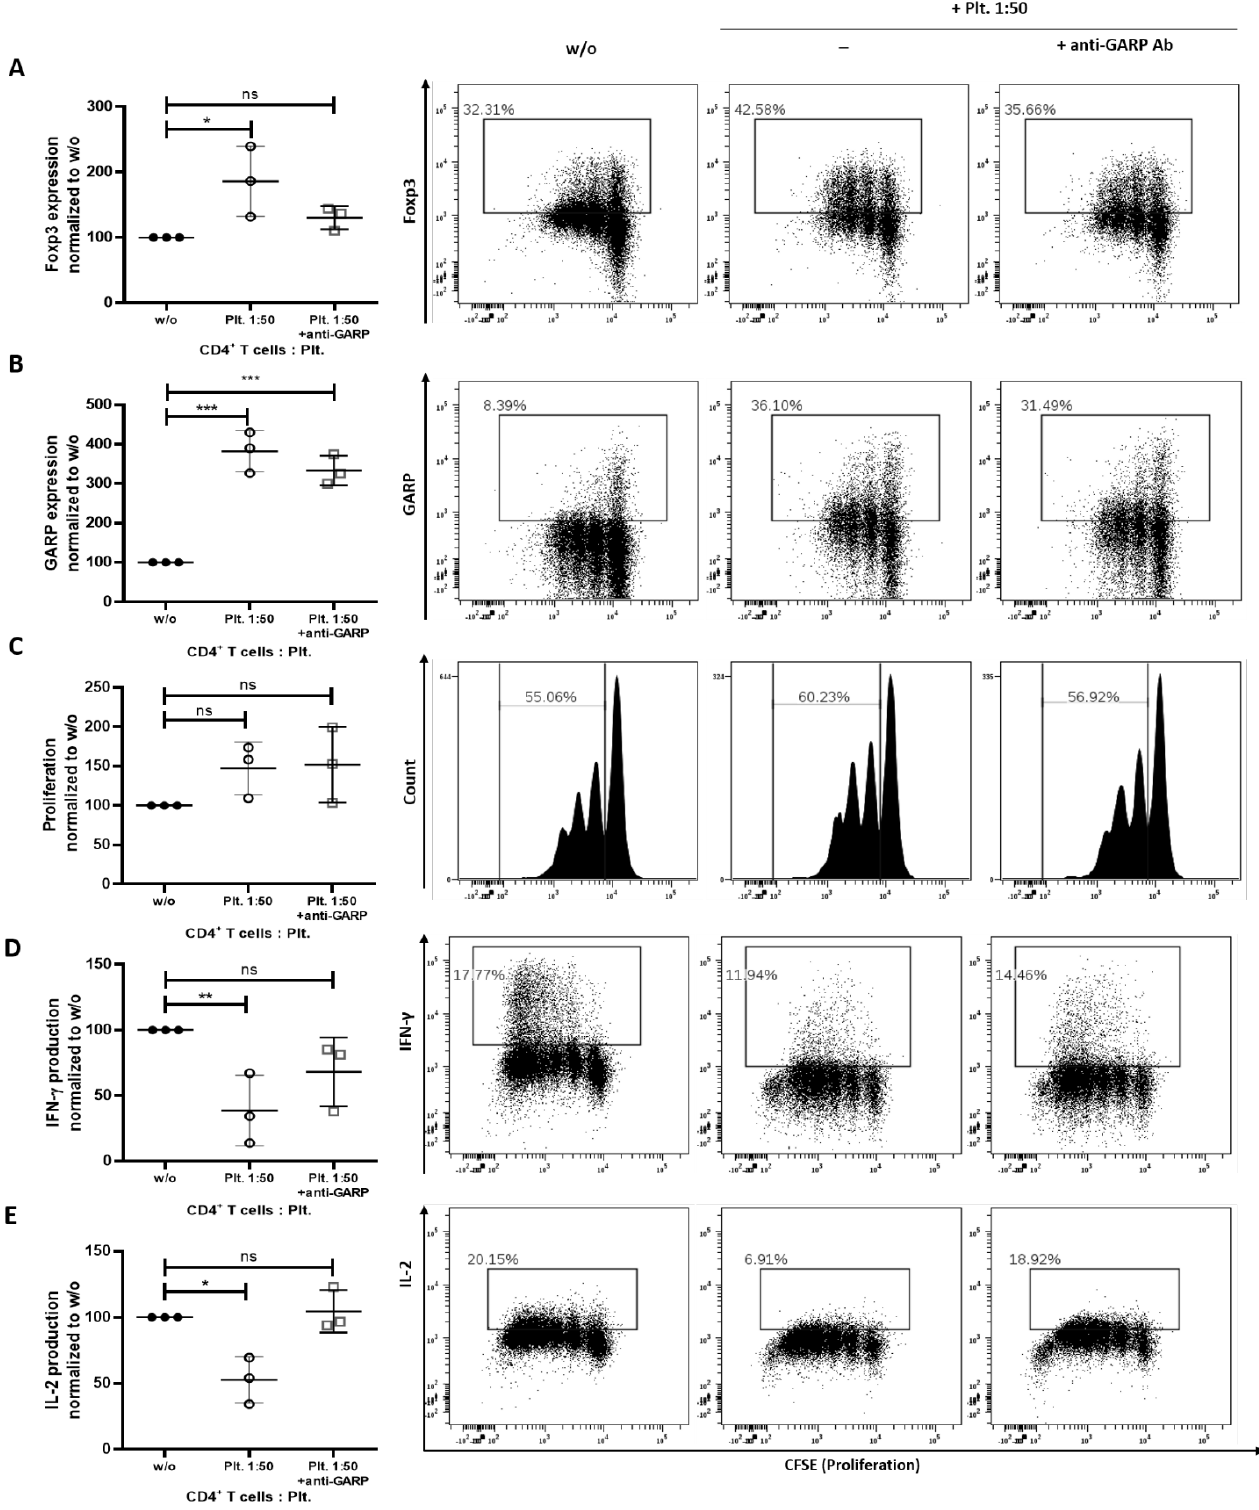
Figure 2. Isolated platelets from liquid platelet rich fibrin (iPRF) induce a regulatory phenotype in CD4 + T cells. CD4 + T cells and platelets (Plt.) were cocultured at a ratio of 1 to 50 and were treated with 10 µg/mL anti-GARP antibody (Ab). CD4 + T cells were prelabled with carboxyfluorescein succinimidyl ester (CFSE) to track their proliferation and stimulated with 0.5 µg/mL anti-CD3 and 1.0 µg/mL anti-CD28 Abs in the presence or absence of platelets. ( A – C ) The expression of Foxp3 ( A ), GARP ( B ), and proliferation ( C ) of CD4 + T cells was measured on day 3 of coincubation via flow